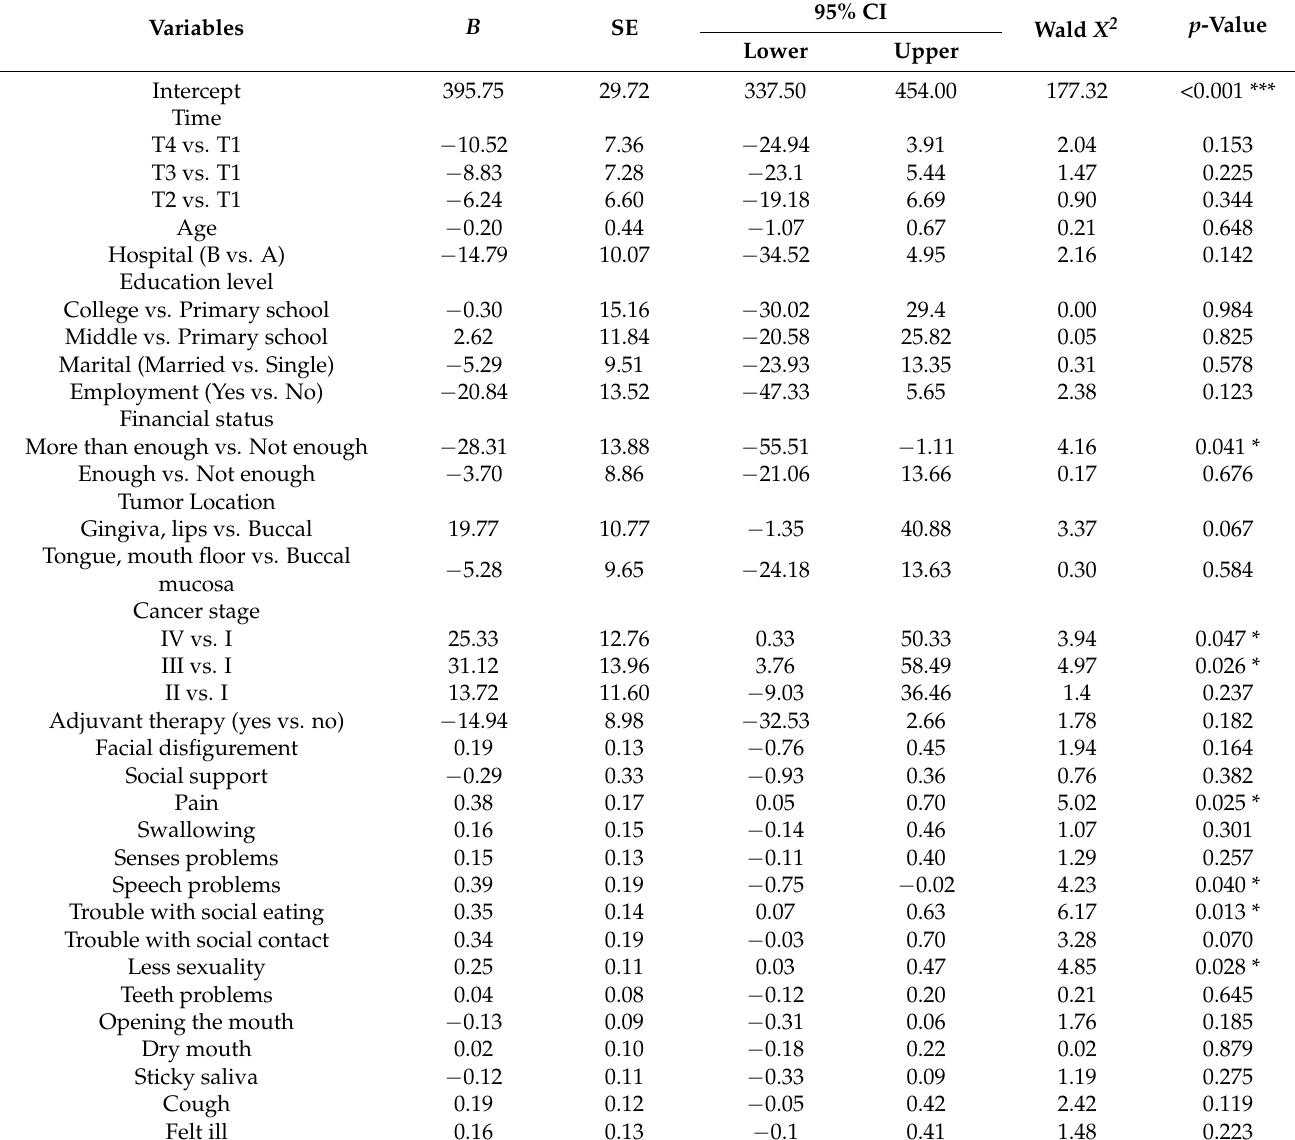
Table 3. Factors associated with psychosocial adjustment ( n =